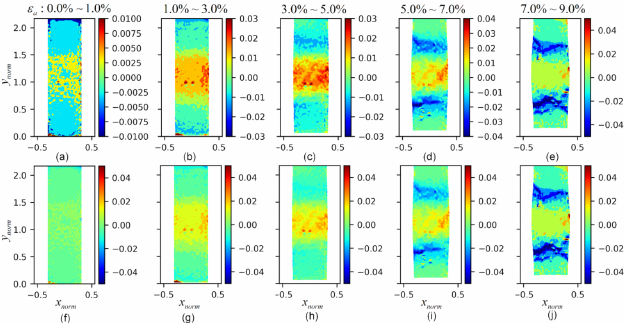
Figure 11. The evolution of the mean fields of divergence div U : ( a – e ) the mean fields of div U at axial strains of 0.0–1.0%, 1.0–3.0%, 3.0–5.0%, 5.0–7.0%, and 7.0–9.0%, respectively, with varying range colormaps; ( f – j ) the mean fields of div U at axial strains of 0.0–1.0%, 1.0–3.0%, 3.0–5.0%, 5.0–7.0%, and 7.0–9.0%, respectively, with consistent range colormaps.